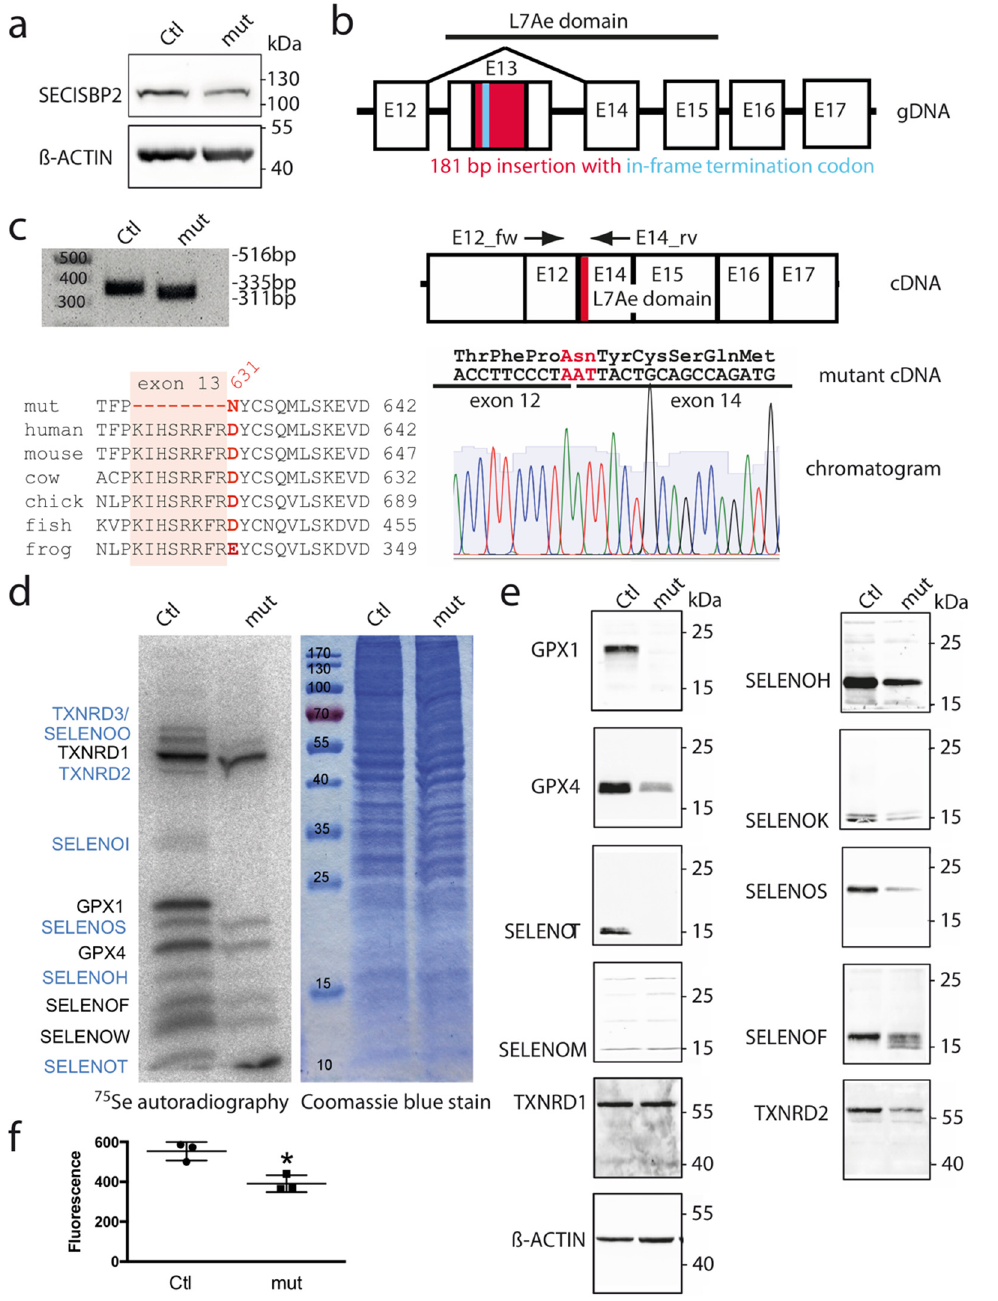
Figure 1. Selenoprotein expression is decreased in SECISBP2 -mutant HAP1 cells. ( a ) Western blot against SECISBP2 shows reduced expression of SECISBP2 in the mutant (mut) cell line compared with the parental cells (Ctl). ( b ) CRISPR-mediated insertion of 181 bp (red) into exon 13 (E13) resulted in an in-frame UGA codon (turquoise) shortly after the insertion site, which was expected to terminate translation at the beginning of the essential L7Ae domain. ( c ) Skipping of exon 13 in SECISBP2 -mut cells. PCR with primers located in exons 12 and 14 gives the expected product of 335 bp in Ctl cells, but instead of a 516 bp product resulting from the 181 bp insertion, a size of 311 bp is observed. Direct sequencing confirms exon skipping and the Asp631Asn mutation. Alignment of amino acid sequences shows that exon 13 (shaded) is conserved from zebrafish to human. Accession numbers are given in Figure A1. ( d ) Metabolic 75 Se-labelling of selenoproteins. Autoradiography of SDS-PAGE. Tentative assignments are labeled in blue. Coomassie staining confirms equal loading. Molecular weight markers are indicated. ( e ) Immunoblot analyses of selenoproteins. ( f ) Thioredoxin reductase activity. Cytosolic extract was assayed using the insulin assay. N = 3. * p < 0.05 Two-sided Student’s t test.